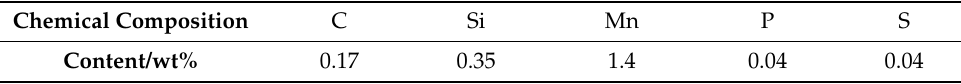
Table 1. Chemical composition and percentage content of Q235 steel. Chemical